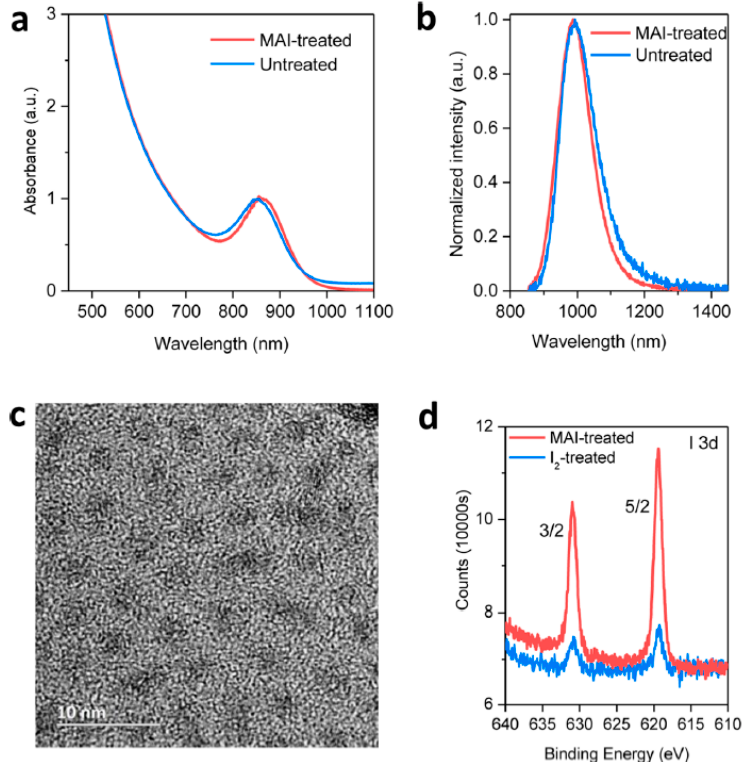
Figure 4. Characterization of PbS CQDs with different treatments. ( a ) Absorption spectra of PbS CQDs depending on methylammonium iodide (MAI) treatment. ( b ) Photoluminescence spectra of PbS CQDs depending on MAI treatment. ( c ) High-resolution transmission electron microscopy (HR-TEM) image of MAI-treated PbS CQDs showing no fusion. ( d ) Quantitative measurements by XPS. I 3D peak of both I 2 -treated and MAI-treated PbS CQDs, showing large enhancement of I-incorporation for the MAI case. Reprinted from reference [27]. Copyright 2016 American Chemical Society.